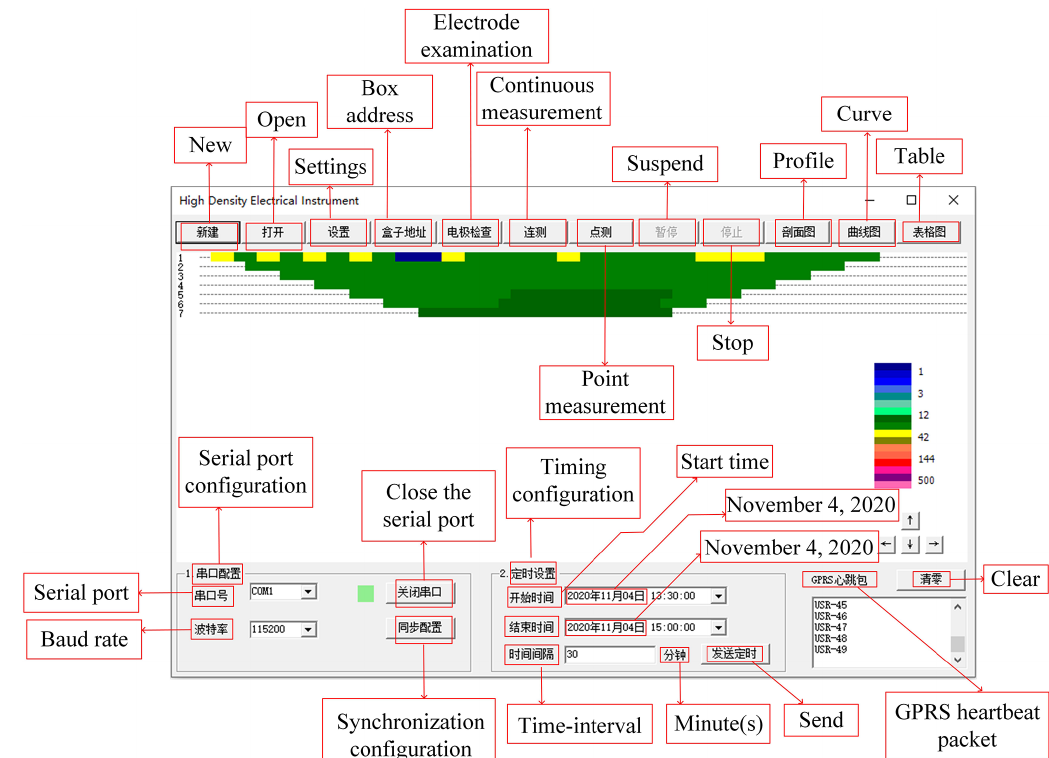
Figure 12. Real-time profile view of the test site as displayed on the remote